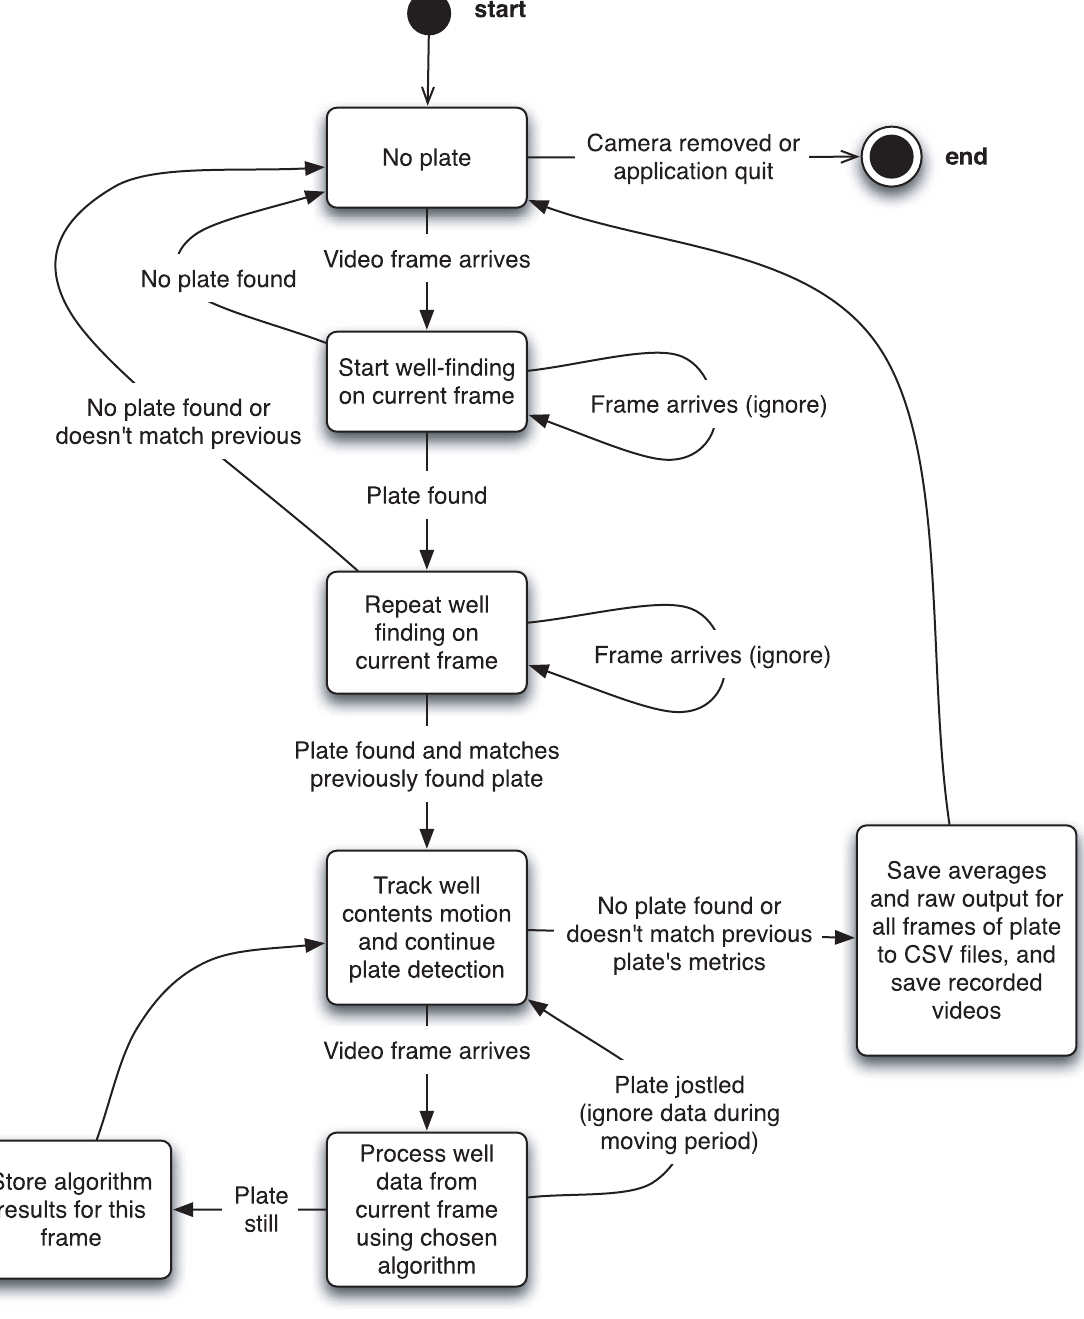
Figure 4. Simplified state machine of the plate detection and tracking logic. The nodes indicate distinct states (or the start/end pseudostates) and the edges indicate transition